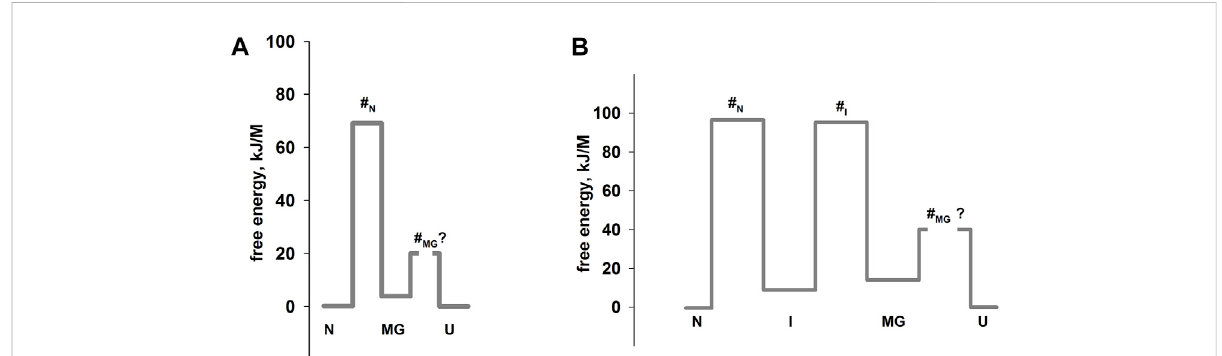
FIGURE 1 Free energy pro fi les for apomyoglobin (A) and carbonic anhydrase (B) . N, native state; I, intermediate state; MGi, molten globule intermediate state; #, transition state; U, unfolded state. The free energy pro fi les shown in the fi gure were calculated for conditions when native and unfolded states of proteins are equal in their stability. For apomyoglobin it is 11 ° C, pH 6.2, 2.7 ° M urea concentration (Baryshnikova et al., 2005b) [ref], for carbonic anhydrase 20 ° C, pH 8.0, 6.2 ° M (Melnik et al., 2008) [ref]. The question mark next to # MG means that the rate of molten globule state formation cannot be measured experimentally.